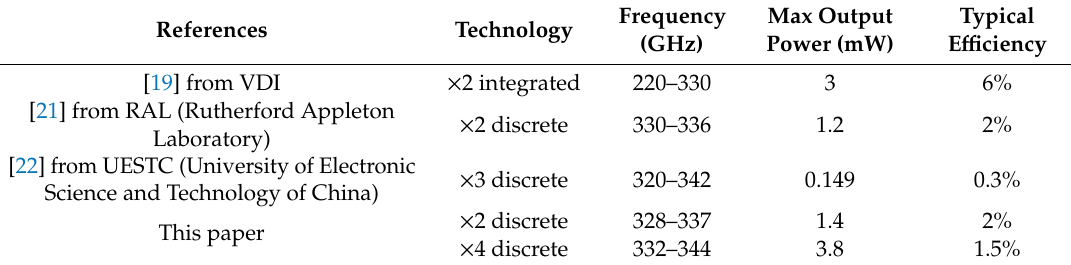
Table 2. Performance comparison of the frequency multipliers above 300